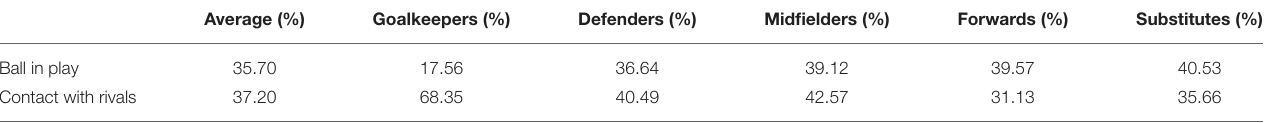
TABLE 1 | Type of contact: ball in play and rivals. Average (%) Goalkeepers (%) Defenders (%) Midfielders (%) Forwards (%) Substitutes (%) Ball in play 35.70 17.56 36.64 39.12 39.57 40.53 Contact with rivals 37.20 68.35 40.49 42.57 31.13